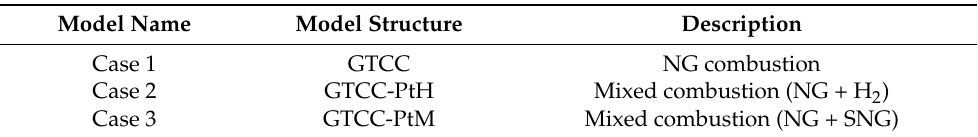
Table 1. Definition of